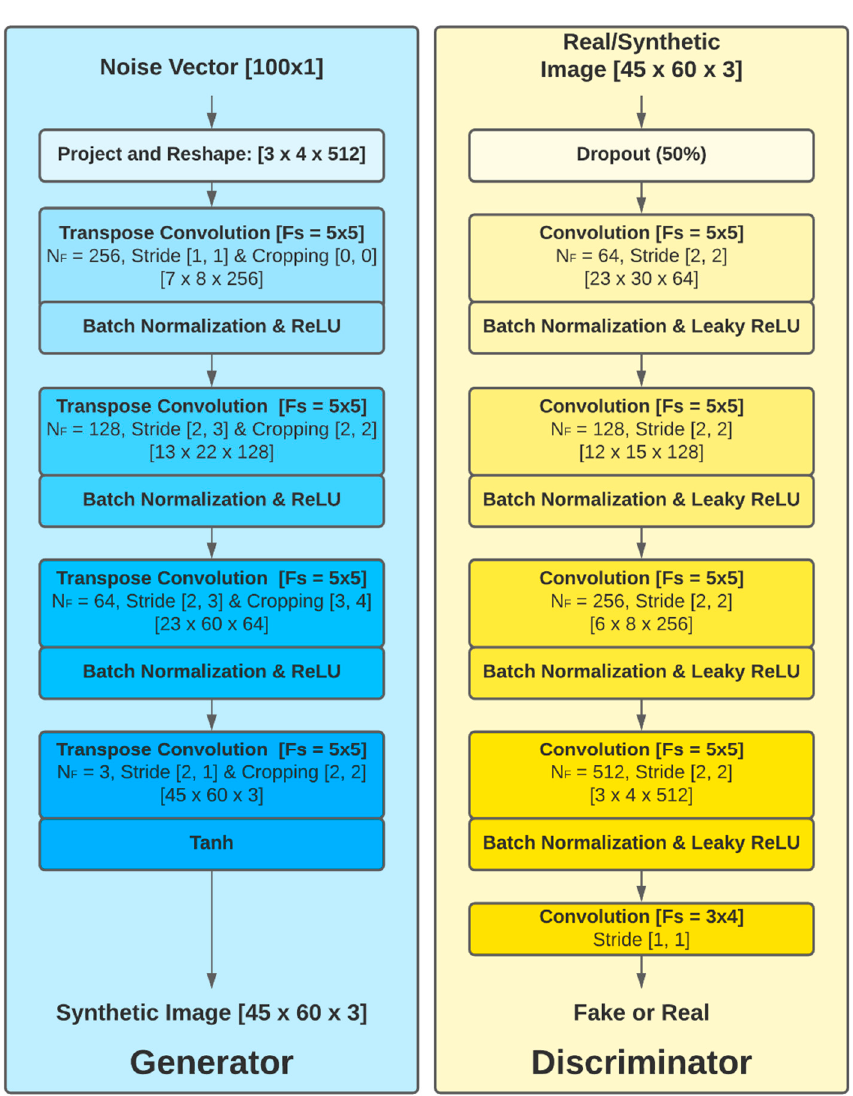
Figure 5. Generator and discriminator architecture. NF: number of filters; Fs = filter dimensions.